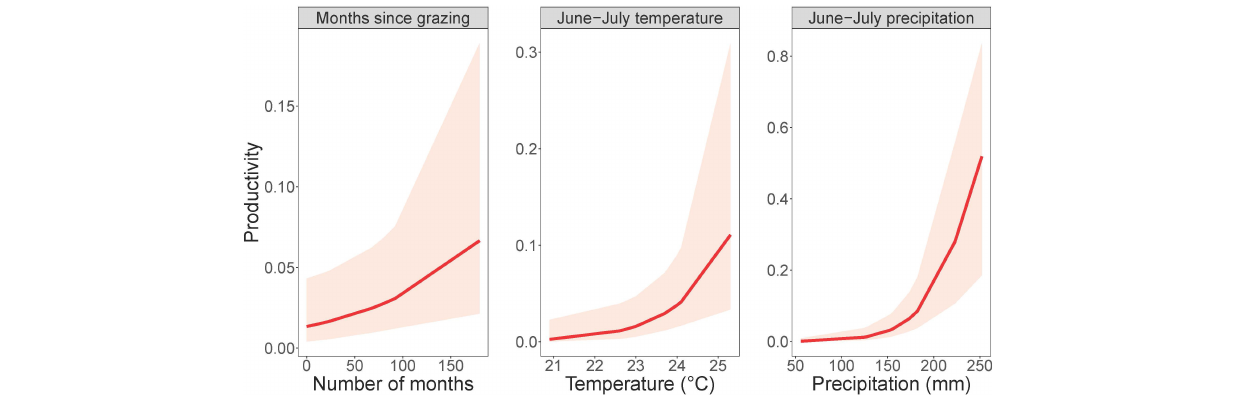
FIGURE 3 | Dickcissel productivity in response to grazing and summer precipitation and temperature. Plots depict (from left to right) months since grazing, mean June-July temperature, and total June-July precipitation plotted against dickcissel productivity, or the probability of encountering a juvenile bird, within 95% confidence